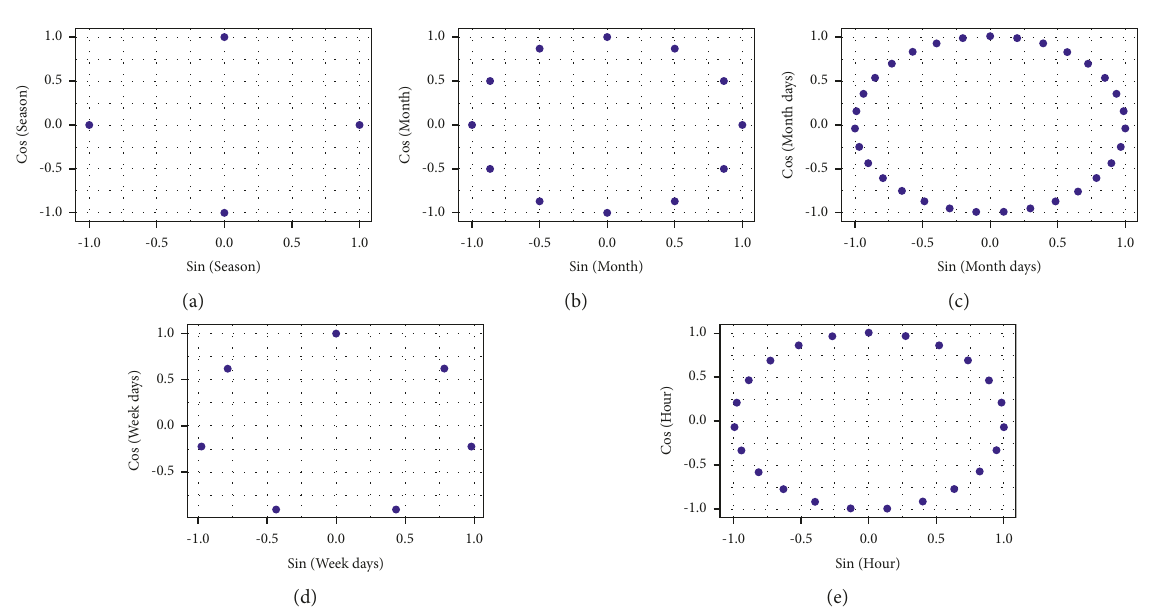
Figure 1: Cyclical features in the dataset. (a) Cyclical seasons, (b) Cyclical solar and lunar months, (c) Cyclical days of a solar or a lunar month, (d) Cyclical days of a week, (e) Cyclical hours of a